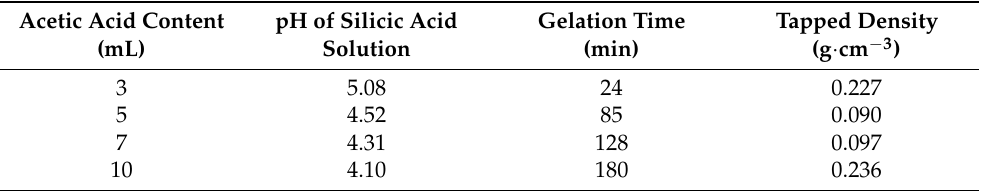
Figure 3. Viscosity of silicic acid solutions at different pH as a function of aging time. Table 1. Gelation time of silicic acid solutions with different pH and tapped densities of silica aerogel powders (concentration of water glass solution: 6.6%).